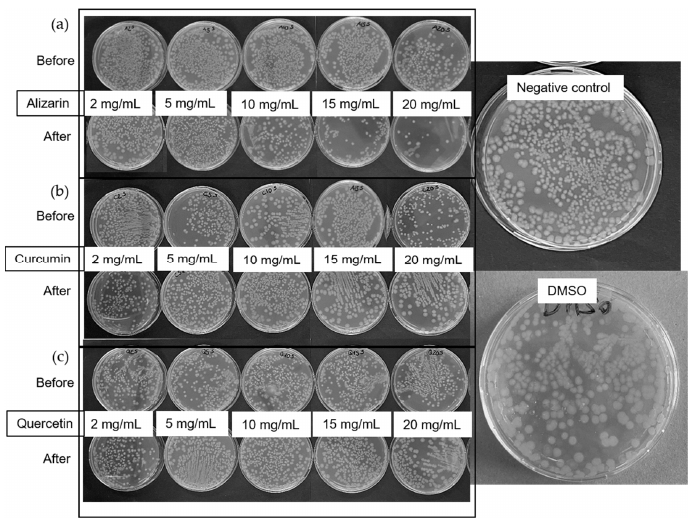
Figure 6. Antibacterial activity testing of ( a ) alizarin, ( b ) curcumin, and ( c ) quercetin against E. coli before and after thermal treatment of the dyes at 230 °C.